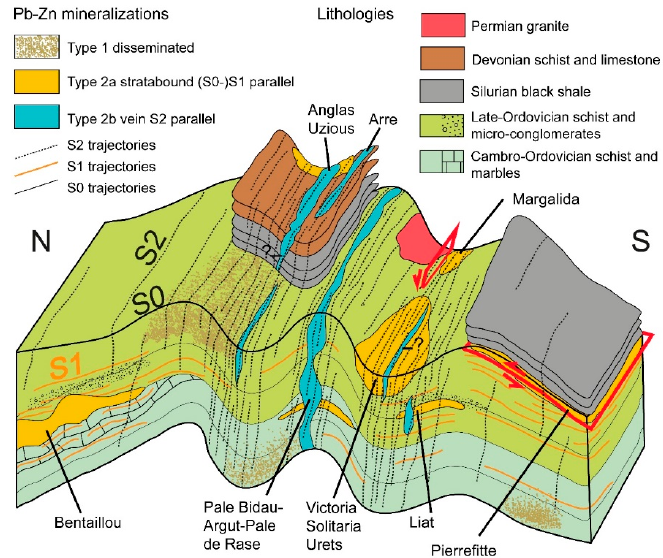
Figure 10. Schematic 3D sketch displaying the three main mineralization types which are typically observed in the studied area and related to each studied deposit. Note cm to pluri-m pull apart geometries in Bentaillou Type 2a mineralizations and in Type 2b mineralizations. Type 2b vein mineralizations are located in intensely S2 deformed domains. Other structural traps like saddle-reef formation in fold hinge or rock competence interfaces are represented for Victoria-Solitaria, Urets, Pierrefitte, and Liat deposits